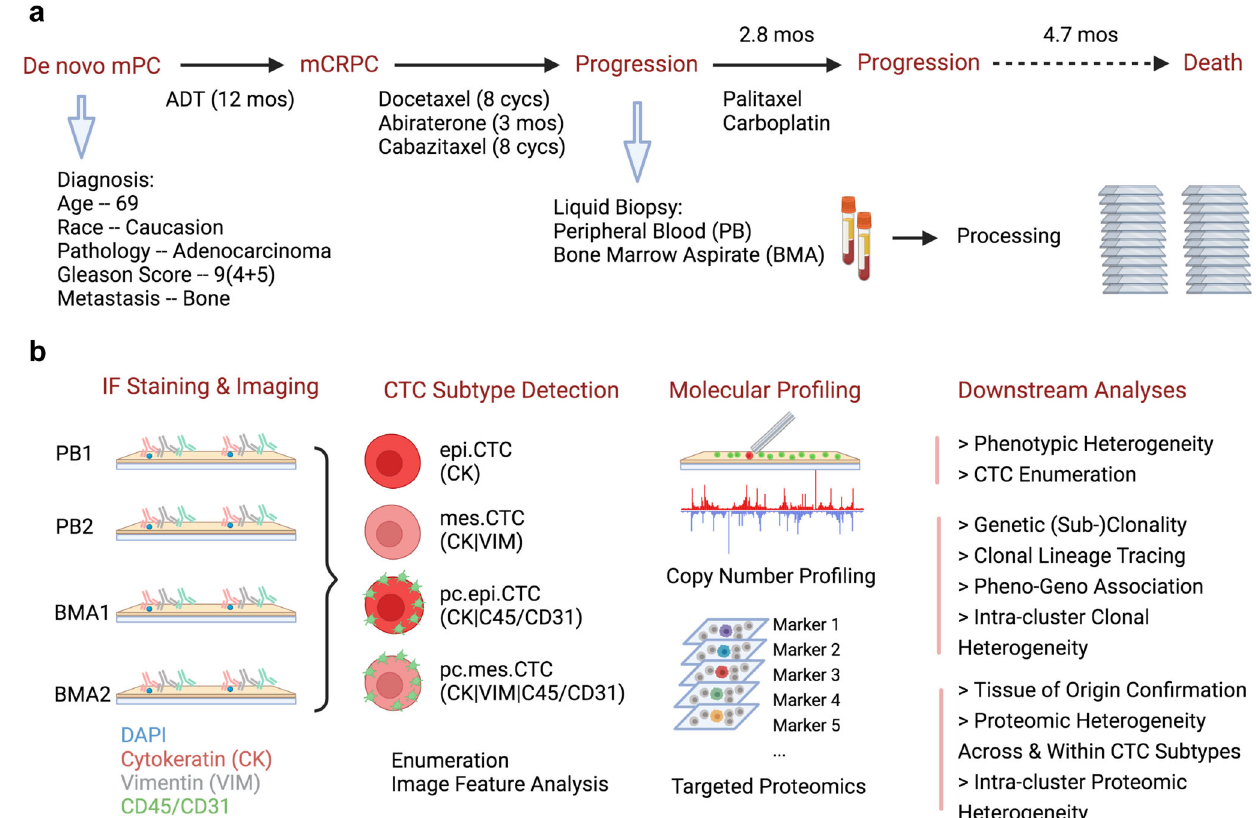
Fig. 1 Patient demographic, pathology, and HDSCA3.0 work fl ow. a Patient ’ s diagnosis, pathology, disease progression, treatment history, and liquid biopsy timepoint. b HDSCA3.0 work fl ow including immuno fl uorescence staining and imaging, rare cell detection, CTC classi fi cation, molecular pro fi ling, and downstream